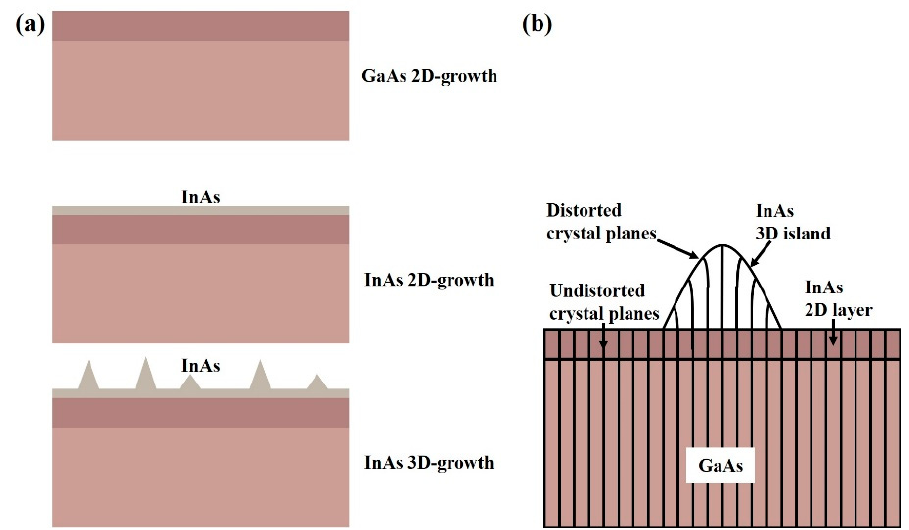
Figure 6. ( a ) Deposition of InAs QDs on the GaAs buffer with S–K growth mode and ( b ) schematic representation of the lattice distortion in a 3D InAs island.